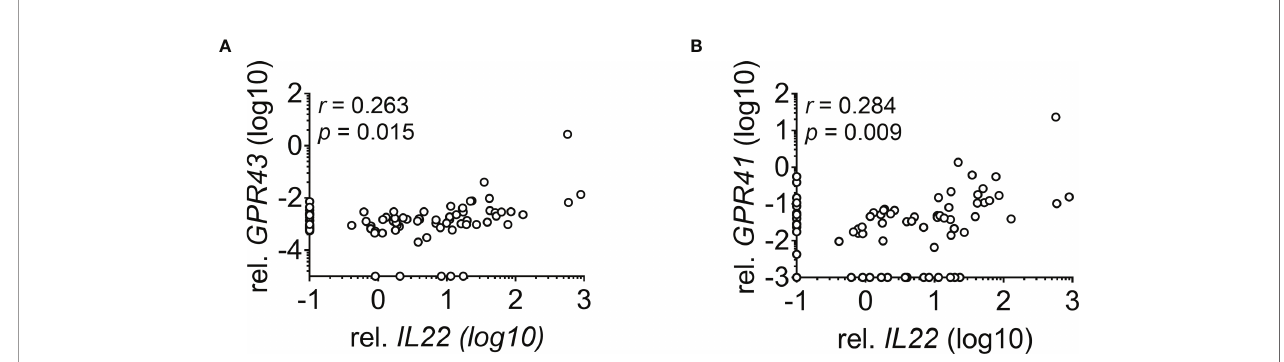
FIGURE 4 | Correlation between IL22 and GPRs. Correlation of IL22 with (A) GPR43 (n = 85) and (B) GPR41 (n = 84) in biopsies derived from the lower GI tract is depicted. Negative values for IL22 were set to 0.1, for GPR43 to 0.00005 and for GPR41 to 0.001. Statistical testing was performed using Spearman`s